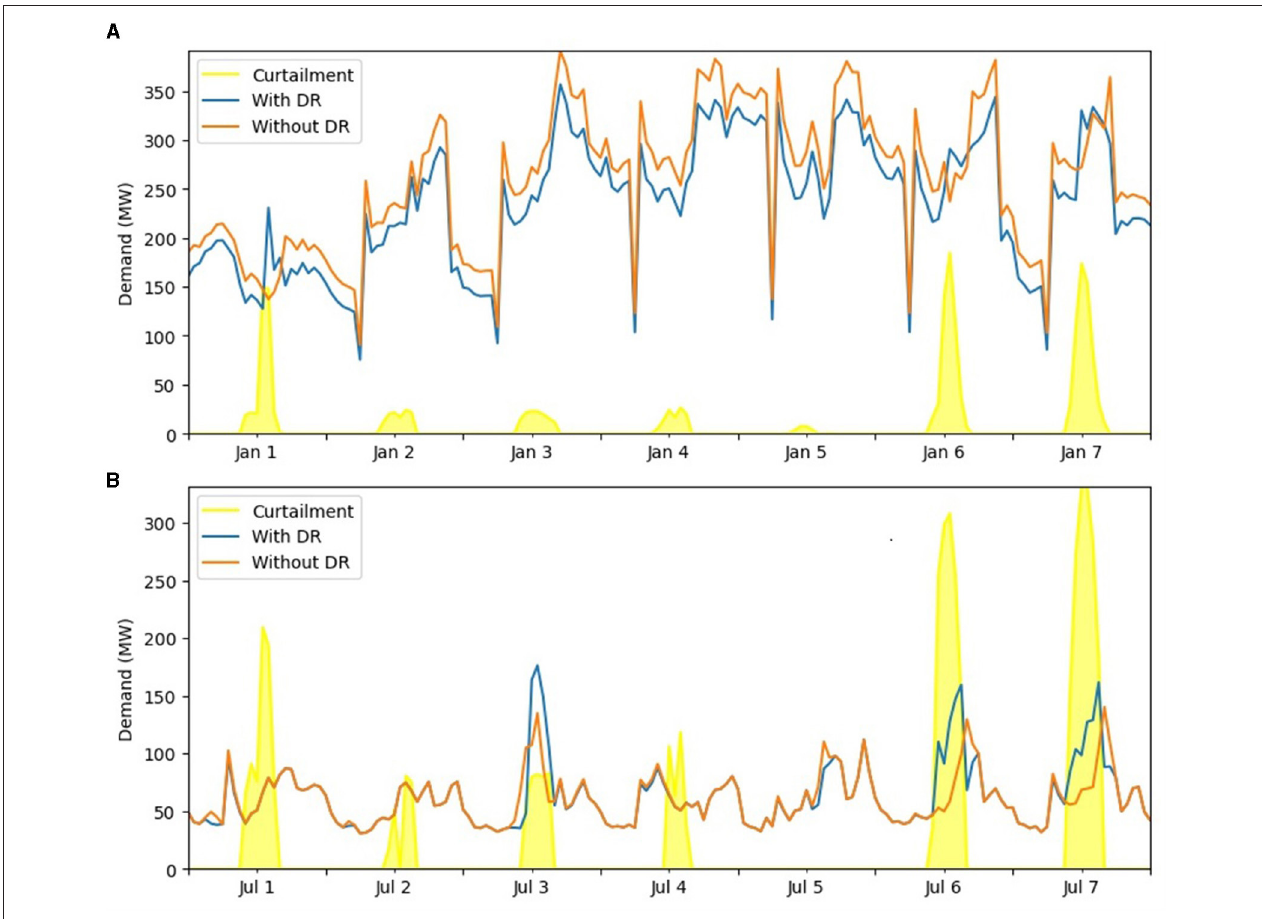
FIGURE 13 | Time-shifting of building demand load due to curtailment within Scenario 3B in the (A) winter (top) and (B) summer